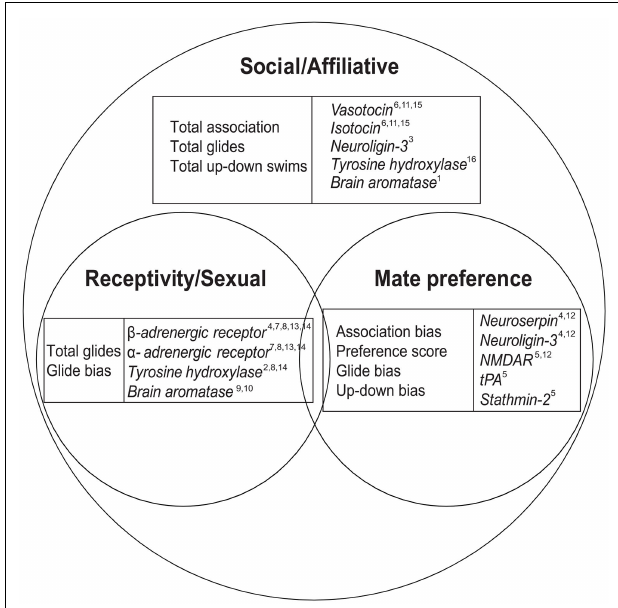
FIGURE 1 | Female social behaviors, brain gene expression, and the subcategories of mate preference and reproduction/sexual behaviors. Venn diagram depiction of the relationships between general female sociality and the subcategories of mate preference and reproduction.We categorize the primary sphere for each of our genes, but some genes (i.e., tyrosine hydroxylase , brain aromatase ) may be listed more than once if they are clearly linked to multiple behavioral categories. Representative citations for category assignment (broad social/affiliative vs. reproduction/sexual behavior or mate preference) are included for reference: 1 Adkins-Regan (2009), 2 Becker et al. (2001), 3 Biswas et al. (2010), 4 Cummings et al.